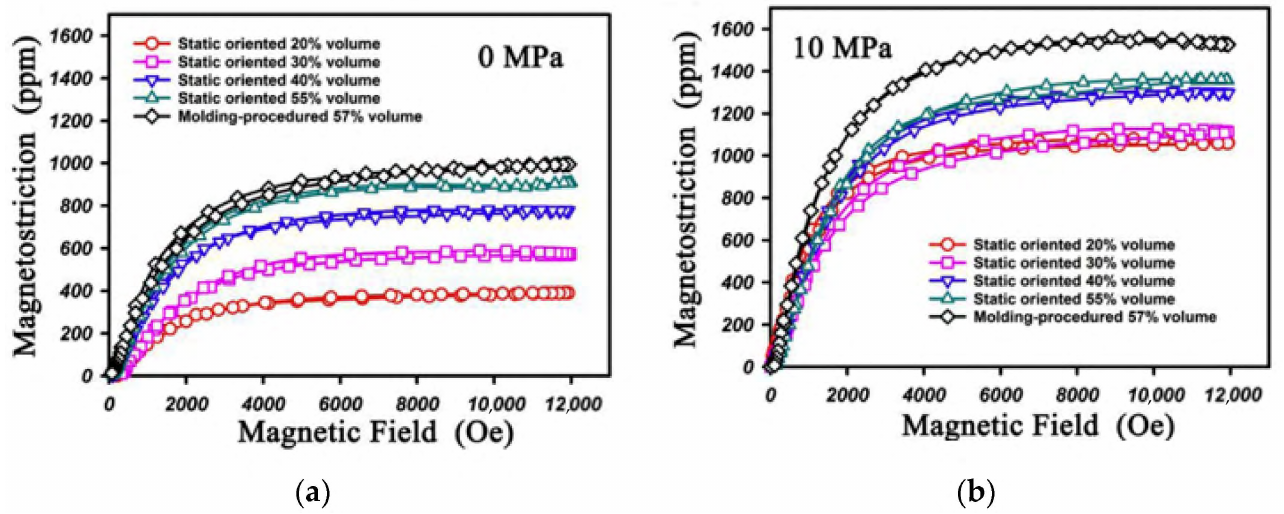
Figure 18. The relationship between magnetostriction and magnetic field strength of composites with different particle volume fractions. ( a ) The pre-compression stress is 0 MPa. ( b ) The pre-compression is 10